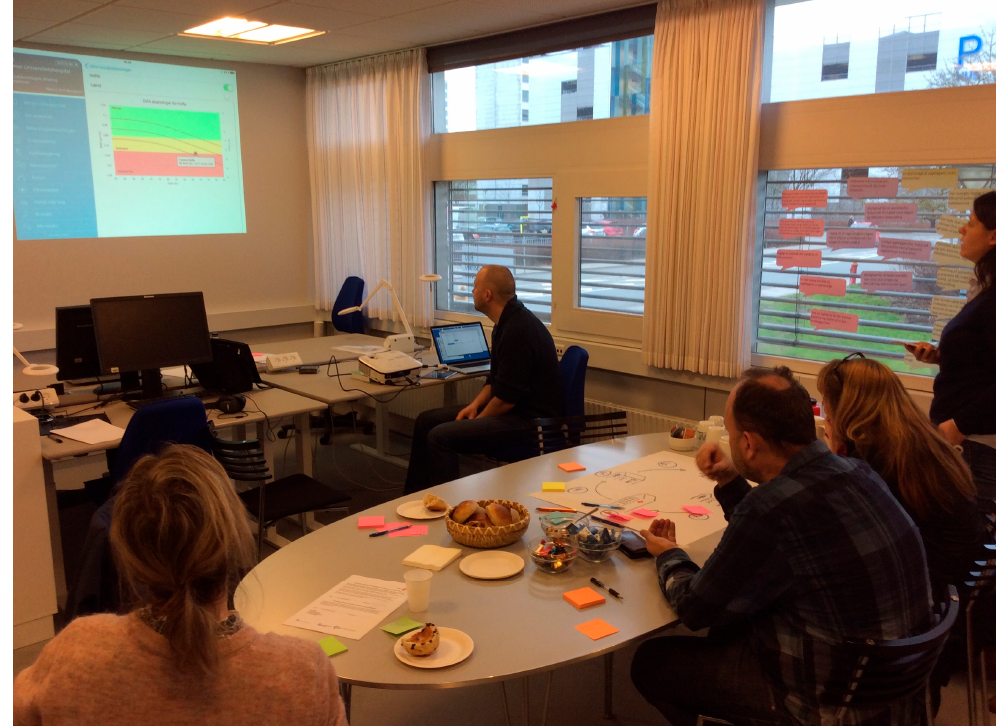
Figure 6. The first laboratory test at the hospital. We tested whether the result of the scan is send through the app, and how the result was illustrated in the graph. We also tested whether the planned material was released if a DXA scan showed that the osteoporosis was present.